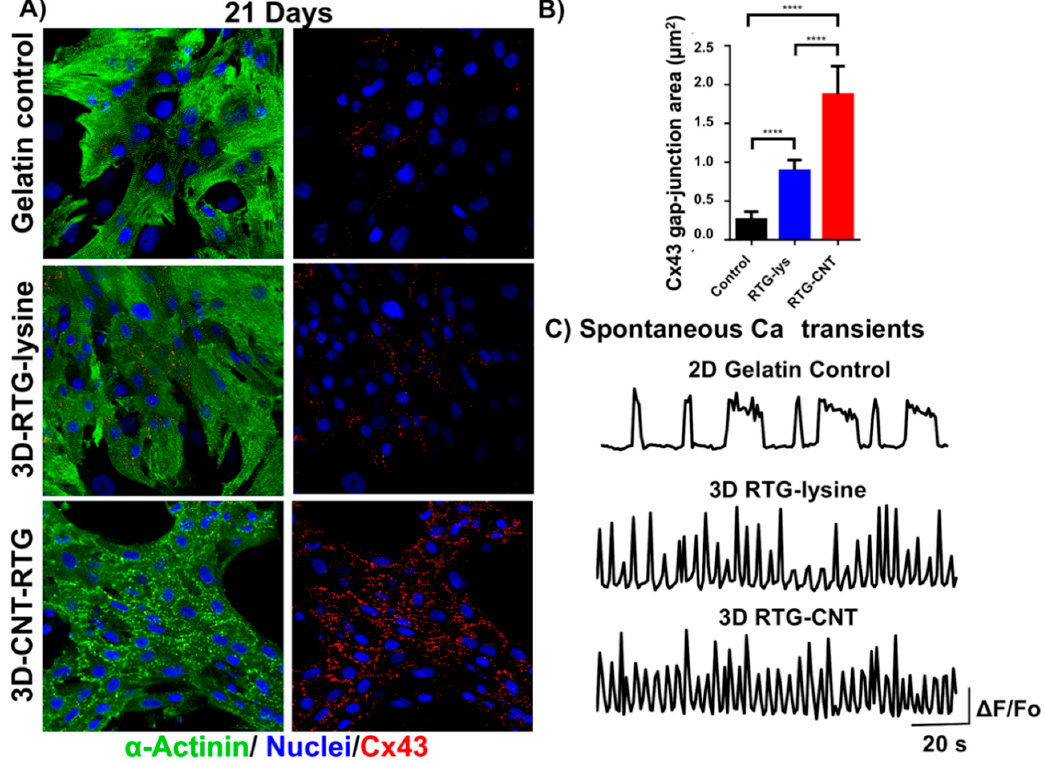
Figure 2. Intercellular communication of neonatal rat cardiomyocytes (NRVMs) growing in different substrates after 21 days of culture. ( A ) Fluorescence images of connexin 43 (red dots), sarcomeric a-actinin (green) and DAPI (blue) staining of NRVMs: top-row panels NRVMs cultured on 2D gelatin control; middle-row panels NRVMs cultured in 3D reversible thermal gel (RTG)-lysine; bottom-row panels NRVMs cultured in 3D RTG-CNT. ( B ) Quantification of Cx43 gap junction area: Significant differences on Cx43 gap-junction were observed between the gelatin control groups and the RTG systems. RTG-lysine “vs.” gelatin control **** p value: <0.0001, n = 8; RTG-CNT “vs.” gelatin control **** p value: <0.0001, n = 8; RTG-CNT “vs.” RTG-lysine **** p value: <0.0001, n = 5. Data are presented as mean ± S.D. ( n = 5). (ANOVA-Bonferroni’s test). Data are presented as mean ± S.D. ( n = 5). ( C ) Spontaneous calcium transients of NRVMs growing on 2D gelatin control and in 3D RTG systems ( n = 5). Reprinted with permission from [66] Copyright 2017 American Chemical Society.